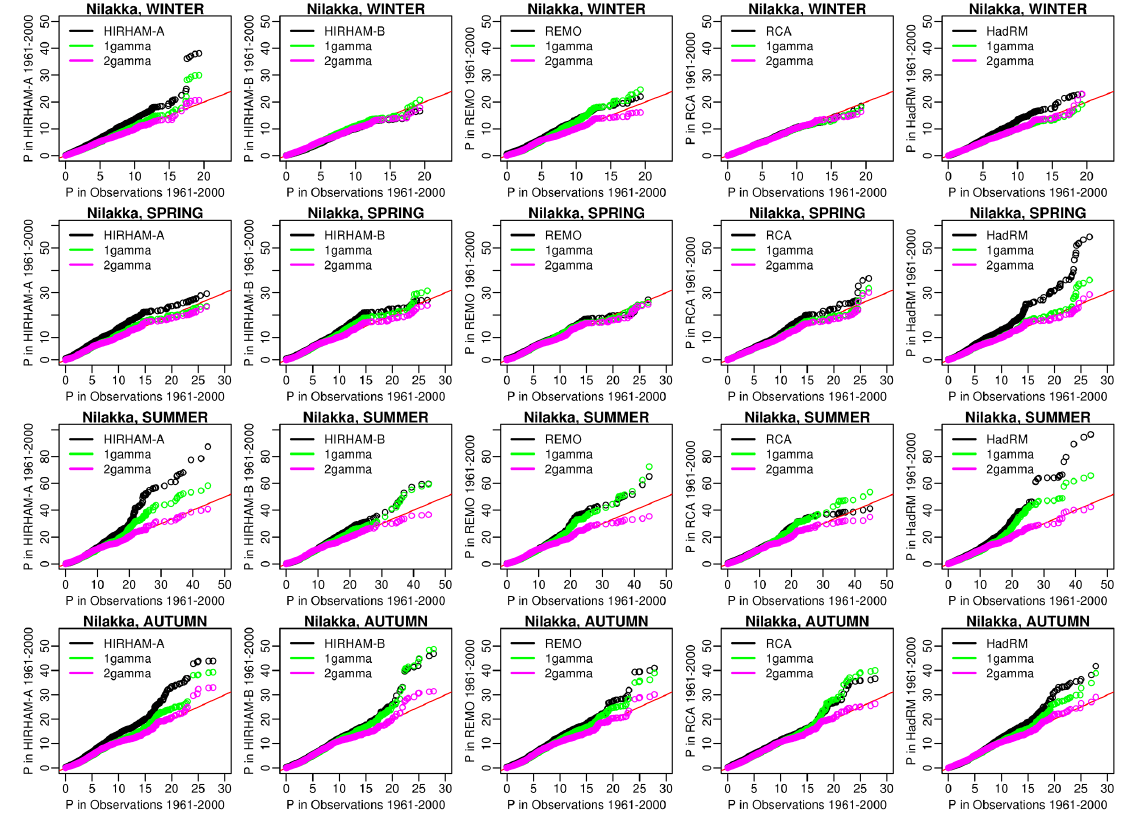
Figure 8. Comparison between uncorrected (black) and DBS-adjusted daily precipitation (single gamma in green and double gamma in pink) during control period 1961–2000 in Nilakka. Red line corresponds to the